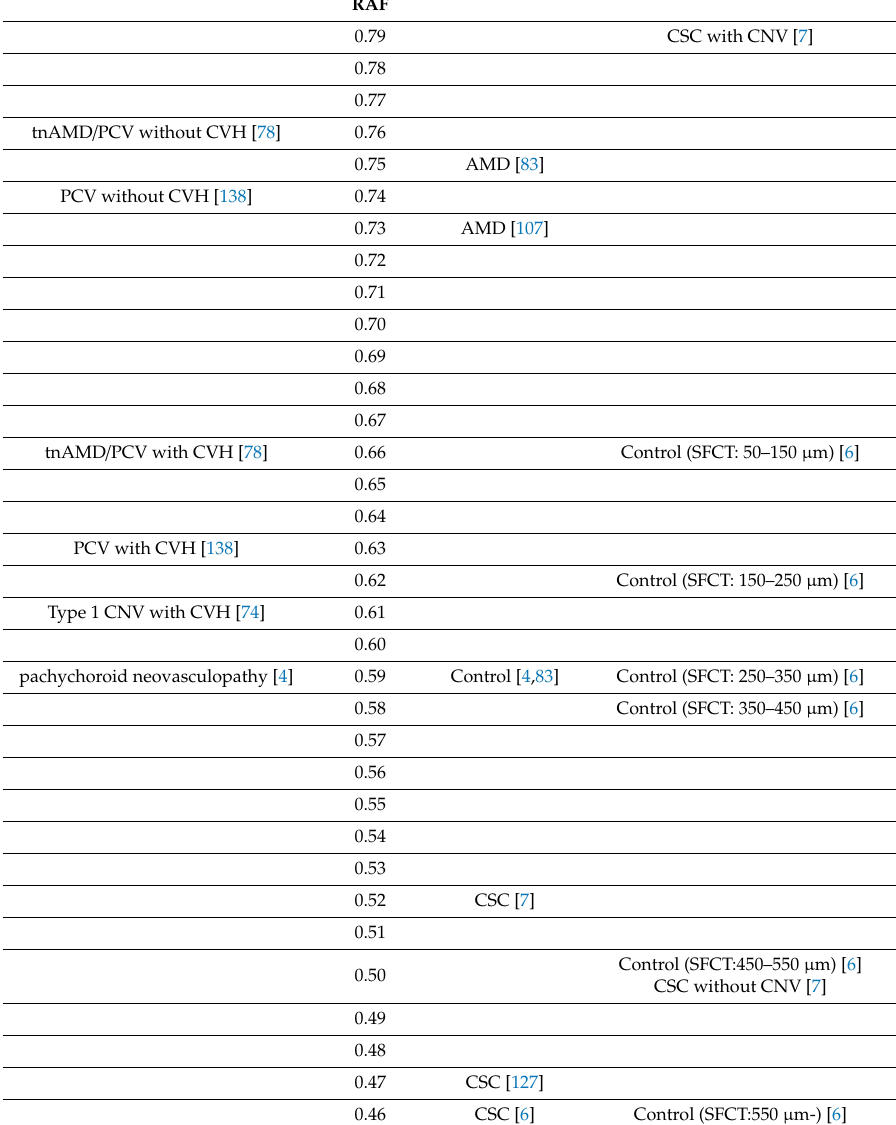
Table 8. Previously reported risk allele frequencies of CFH I62V in Japanese.